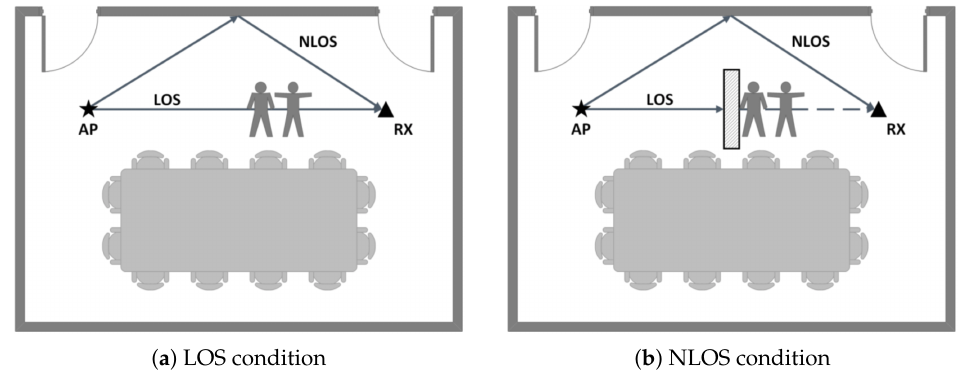
Figure 14. The scenario of human motion detection